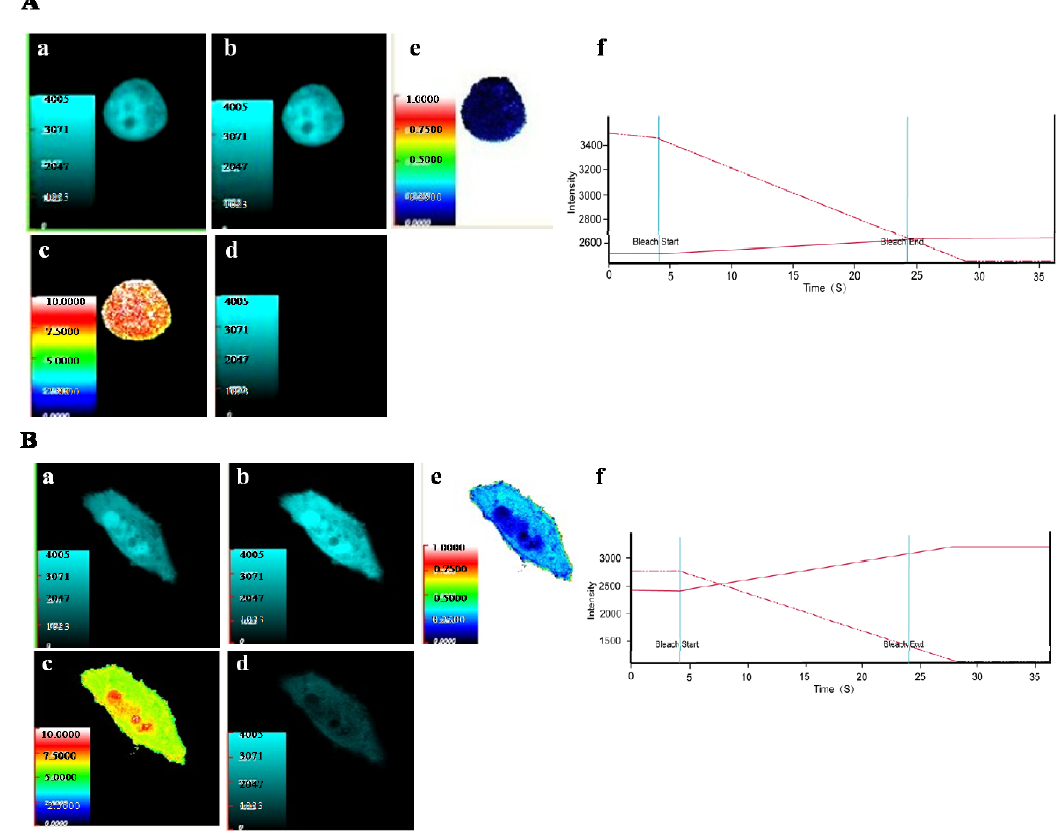
Figure 2. Fluorescence resonance energy transfer (FRET) analysis of the interaction between SelM' and Gal-1. ( A ) Representative laser scanning microscopy images of HeLa cells cotransfected empty plasmids pECFP-C1 and pEYFP-C1 (negative control). ( a ) The fluorescence image of donor (CFP) before bleaching; ( b ) The fluorescence image of donor after bleaching; ( c ) Diagram of the distance between donor (CFP) and receptor (YFP); ( d ) Donor fluorescence increment before and after bleaching; ( e ) FRET efficiency diagram; ( f ) Photobleaching curve (solid line for donor fluorescence and dashed line for receptor fluorescence); ( B ) Cells co-transfected pECFP-C1- SelM' and pEYFP-C1- Gal-1 . ( a ) The fluorescence image of donor (CFP-SelM') before bleaching; ( b ) The fluorescence image of donor after bleaching; ( c ) Diagram of the distance between donor (CFP-SelM') and receptor (YFP-Gal-1); ( d ) Donor fluorescence increment before and after bleaching; ( e ) FRET efficiency diagram; ( f ) Photobleaching curve (solid line for donor fluorescence and dashed line for receptor fluorescence).